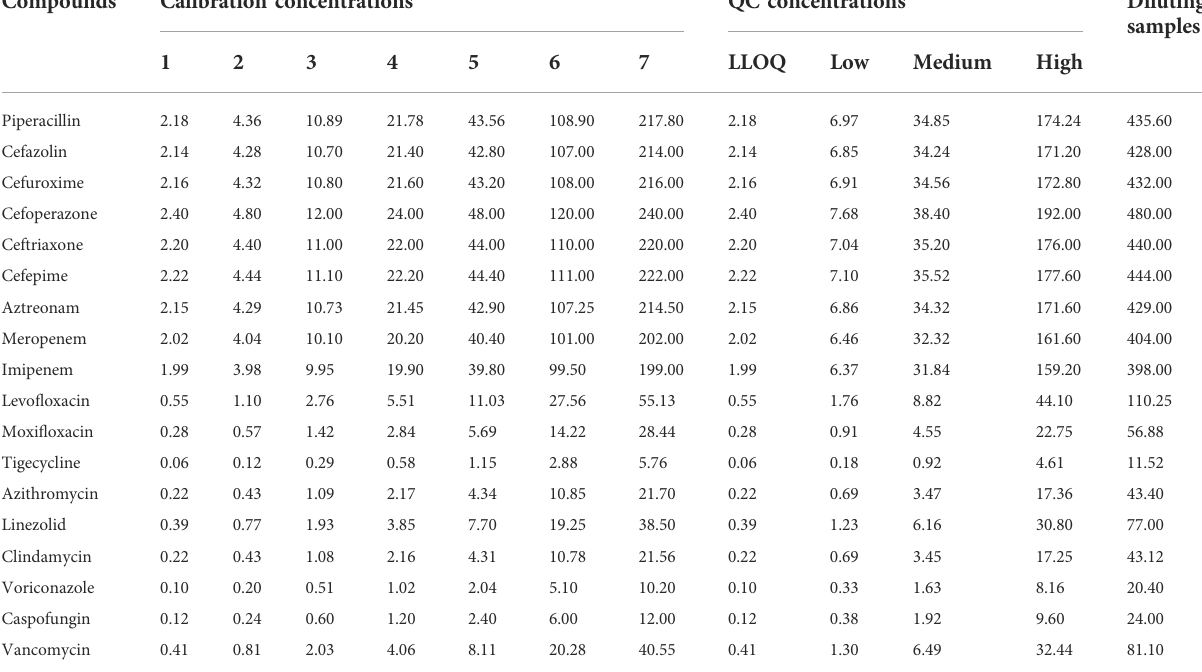
TABLE 2 Concentrations of calibrators and QCs (µg · mL − 1 ). Compounds Calibration